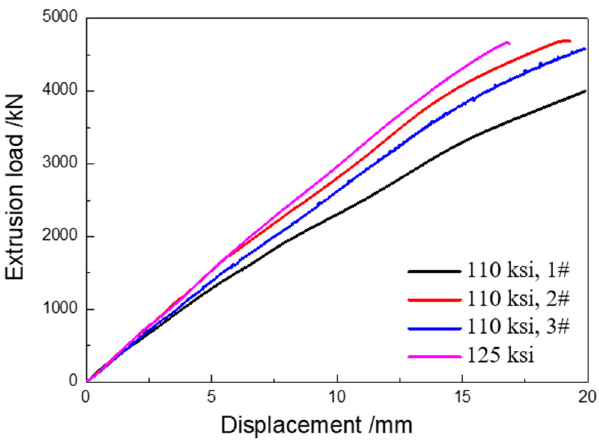
Figure 13. Extrusion load and displacement curve of cement-sheath casing.